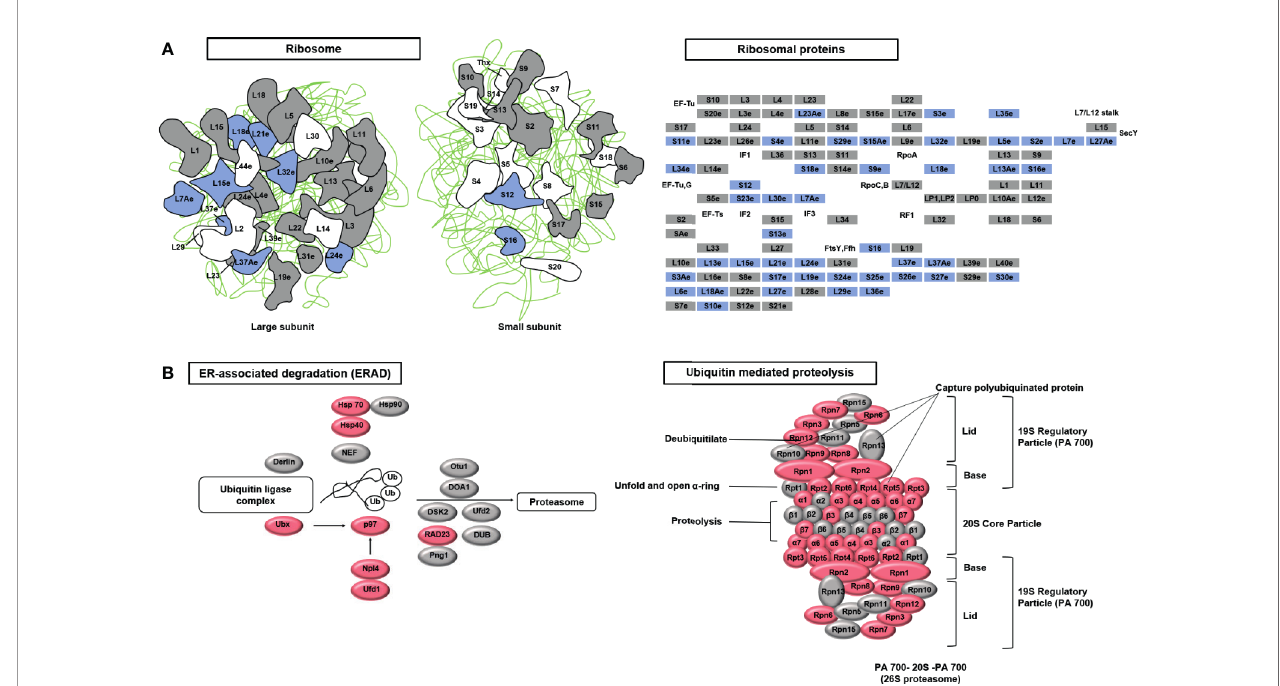
FIGURE 5 | Kyoto Encyclopedia of Genes and Genomes (KEGG) pathways targeted after copper (Cu)-induced accumulation of reactive oxygen species (ROS). (A) The ribosome pathway was down-regulated under Cu stress. The KEGG database was used to identify enriched pathways. A schematic diagram of ribosome subunits from the KEGG database is shown. All proteins in the ribosome pathway that were identi fi ed in the proteomic analysis are displayed in squares. Blue indicates down-regulated proteins ( q -value <0.05) and gray indicates unchanged proteins. (B) Two protein degradation pathways (endoplasmic reticulum-associated degradation and ubiquitin-mediated proteolysis) were up-regulated under Cu stress. All proteins identi fi ed in these two pathways that were identi fi ed in the proteomic analysis are displayed in ellipses. Red indicates up-regulated proteins ( q -value <0.05) and gray indicates unchanged